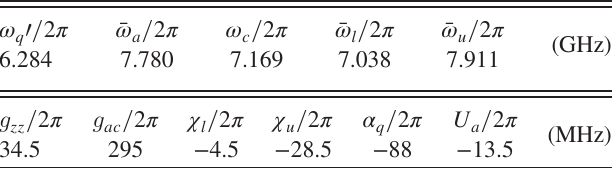
TABLE II. Transition frequencies, anharmonicities, and cou- pling strengths at zero flux Φ ¼ 0 and T ¼ 20